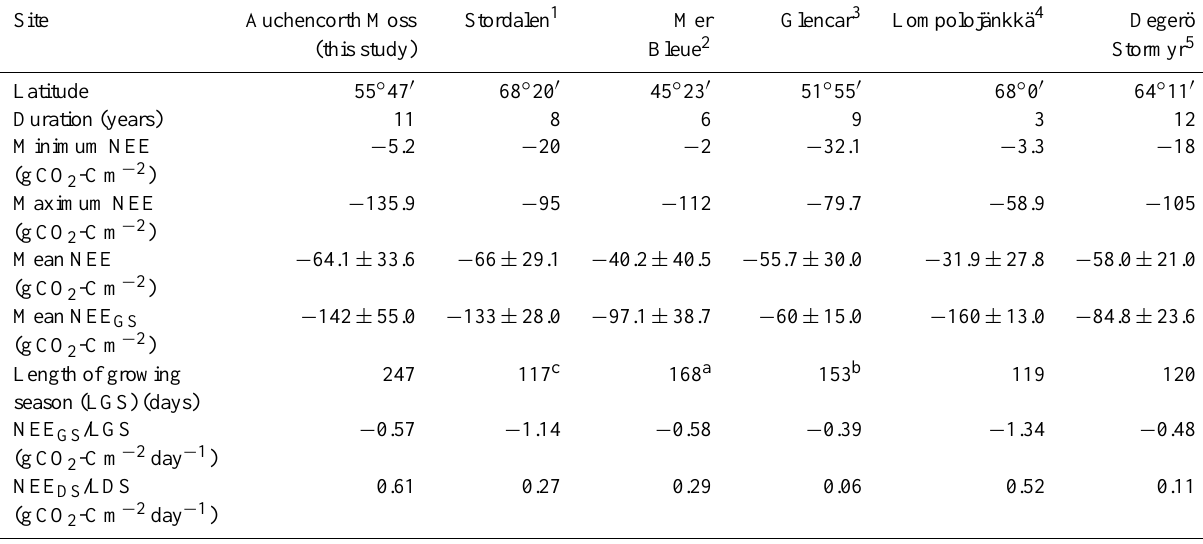
Table 4. Annual minimum, maximum and mean values of NEE at several long-term peatland monitoring sites in the Northern Hemisphere. LGS and LDS are the length of growing and dormant season respectively, and subscripts GS and DS denote growing and dormant season. The length of the growing season for the study site Auchencorth Moss was bounded by the first and last day for which mean daily air temperatures exceeded 5 ◦ C for 5 consecutive days. For the other sites, LGS was estimated from data available in the respective articles. Site Auchencorth